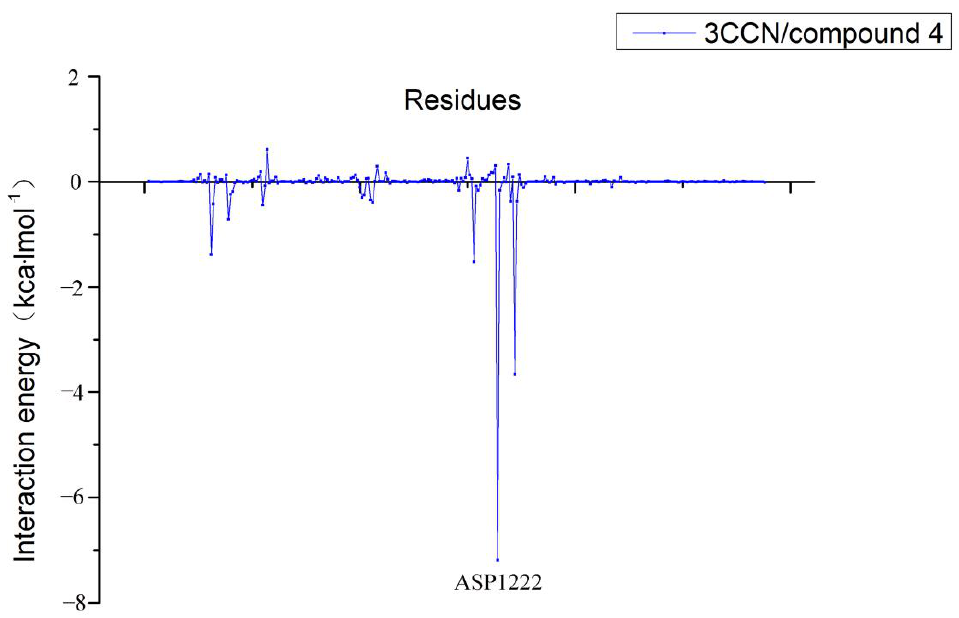
Figure 12. Contribution of partial residues calculated by decomposing the binding energy.